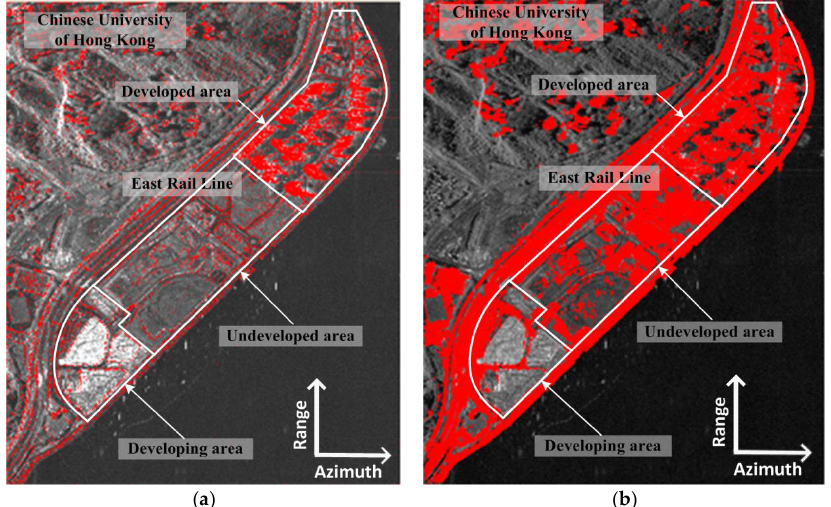
Figure 12. Comparison of MPs at the HKSP site identified by the PSI method ( a ) and the proposed strategy ( b DSI strategy ( b ).